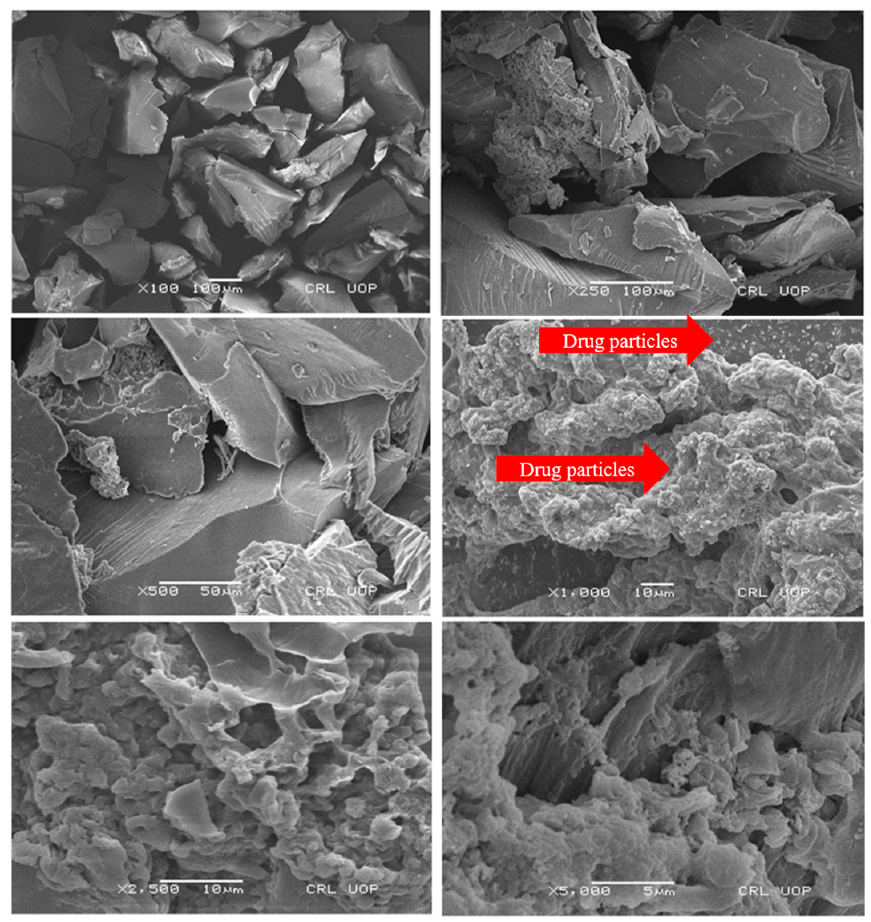
Figure 6. Photomicrographs of MU-CHI-Co-Poly (MAA) hydrogel microparticles.